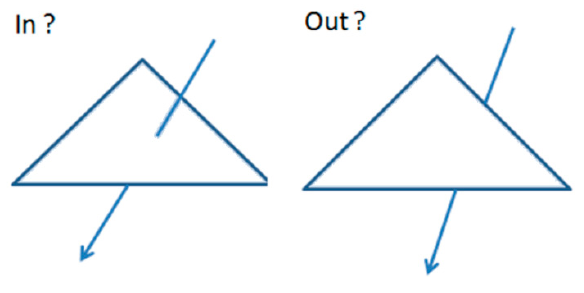
Figure 10. A solar ray in a window.